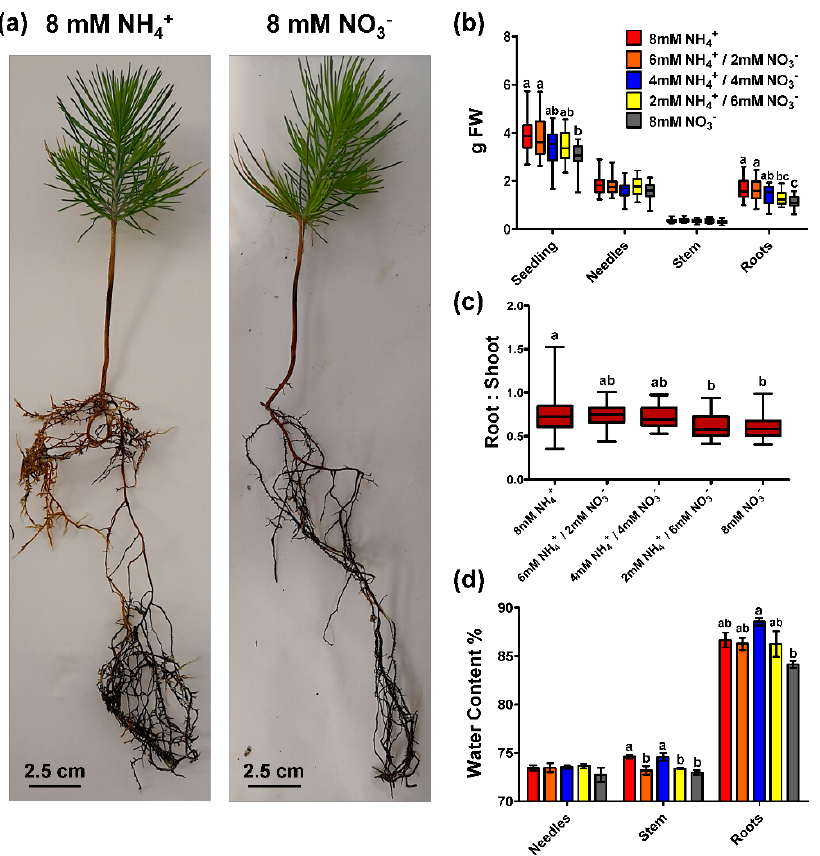
Figure 1. Biomass accumulation, root:shoot ratio, and water content in the different organs (needles, stem, and roots) of pine seedlings under the nutrient treatments. ( a ) Photographs of two seedlings after treatment with 8 mM ammonium and 8 mM nitrate; ( b ) Biomass accumulation in the whole seedling and the different organs (needles, stem, and roots); ( c ) Root:shoot ratio; ( d ) Water content. Red columns correspond to 8 mM NH 4+ supply; orange columns correspond to 6 mM NH 4+ /2 mM NO 3 − supply; blue columns correspond to 4 mM NH 4+ /4 mM NO 3 − supply; yellow columns correspond to 2 mM NH 4+ /6 mM NO 3 − supply; grey columns correspond to 8 mM NO 3 − supply. Significant differences were determined with a one-way ANOVA for each organ or entire seedling. Letters above the columns show significant differences based on a Newman-Keuls post-hoc test ( p < 0.05). Boxplots show minimum, maximum, and median values with n = 6 for biomass and root:shoot ratio. Error bars show SE with n = 3. FW corresponds to fresh weight.